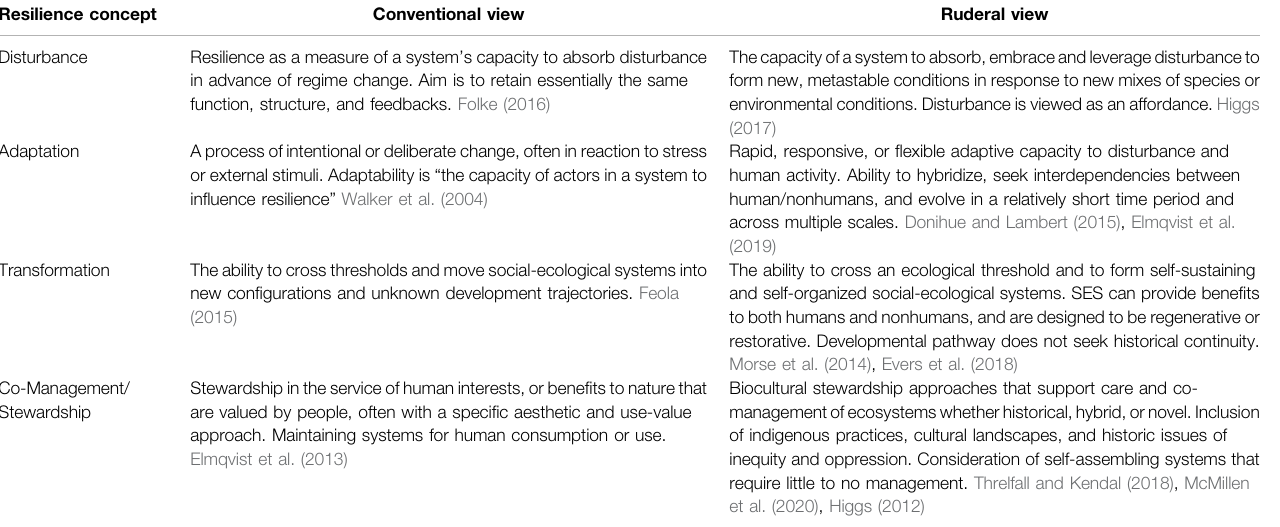
TABLE 1 | A comparison of conventional resilience thinking and ruderal